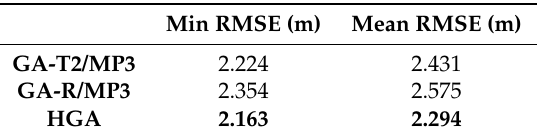
Table 5. RMSE comparison between the different methodologies analyzed. From the results obtained by the executed simulations, Bold Min RMSE refers to the mean RMSE value of the simulation that is the lesser of all simulations executed, whereas Mean RMSE refers to the mean value of mean RMSE of every